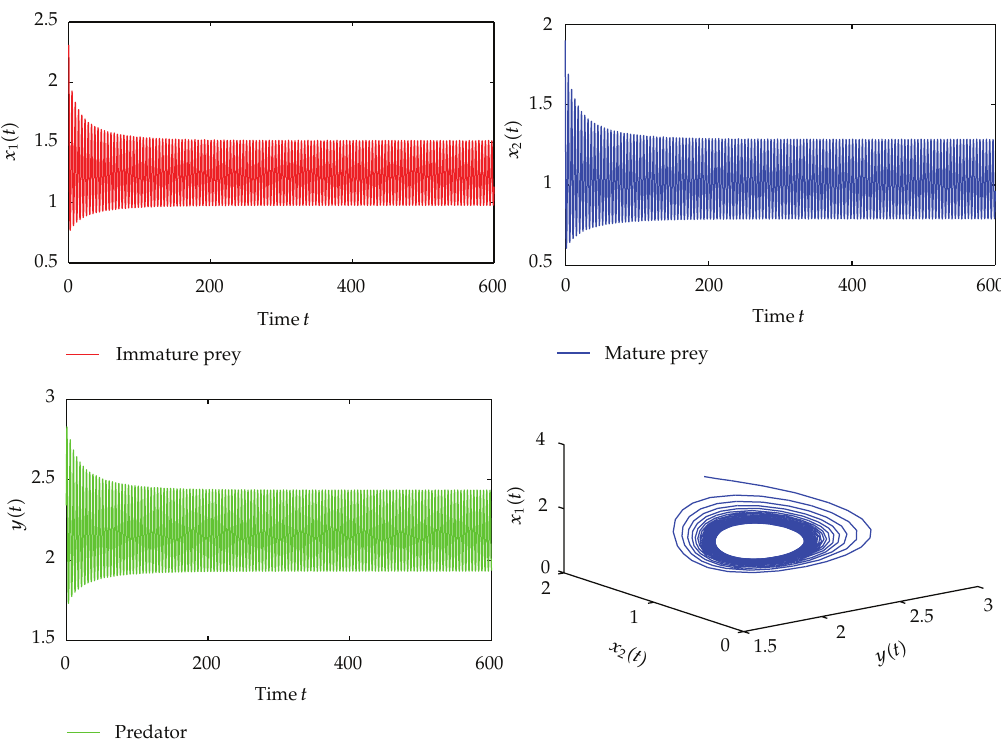
Figure 2: E 0 is unstable for τ 1 (cid:6) 0 . 9200 > τ 10 (cid:6) 0 . 9032 with initial value “2.31; 1.9;